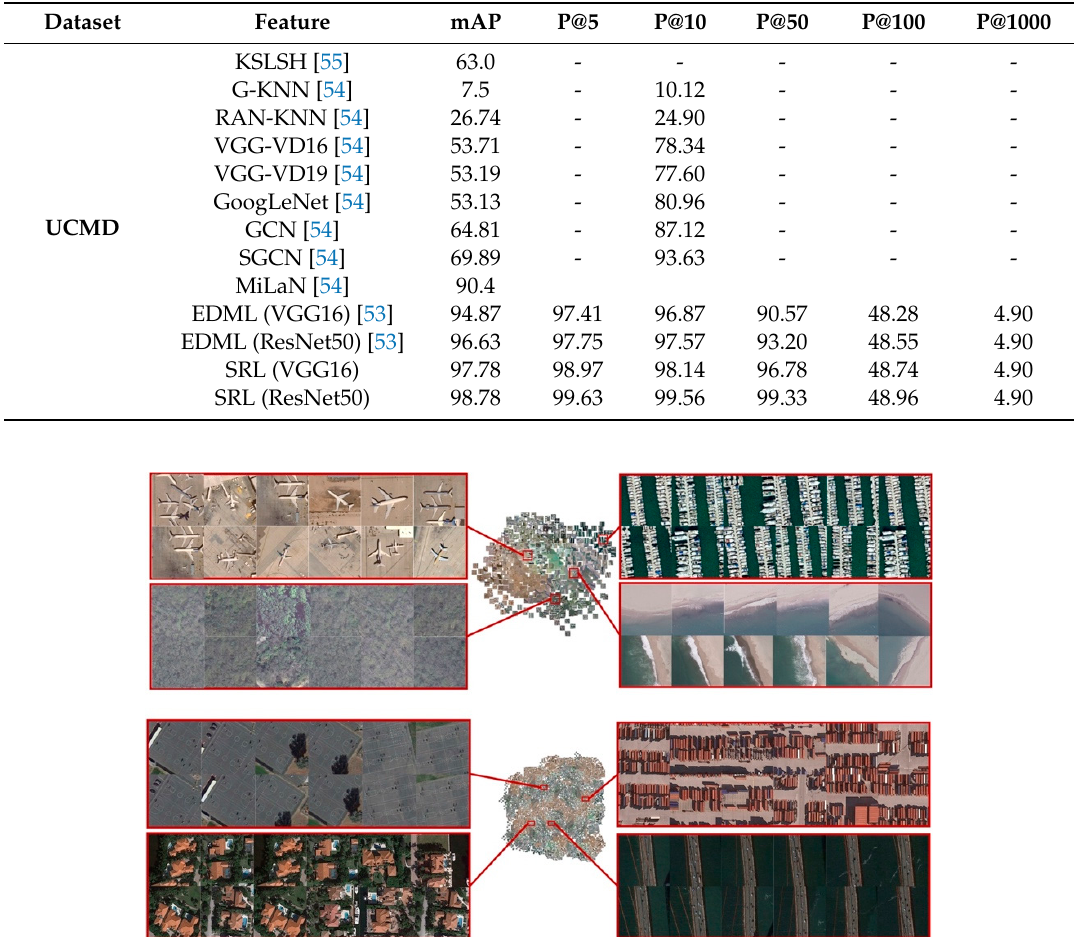
Figure 9. The image retrieval visualized results of PatternNet (bottom) and UCMD (top) trained under the ResNet50. Table 4. Evaluation of mAP which is performed with VGG16 and ResNet50 on per-class in the PatternNet datasets comparing with the pre-trained CNNs.